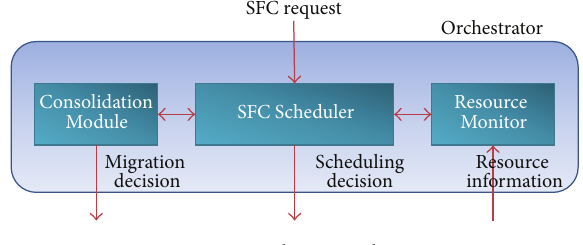
Figure 2: SFC planner architecture.